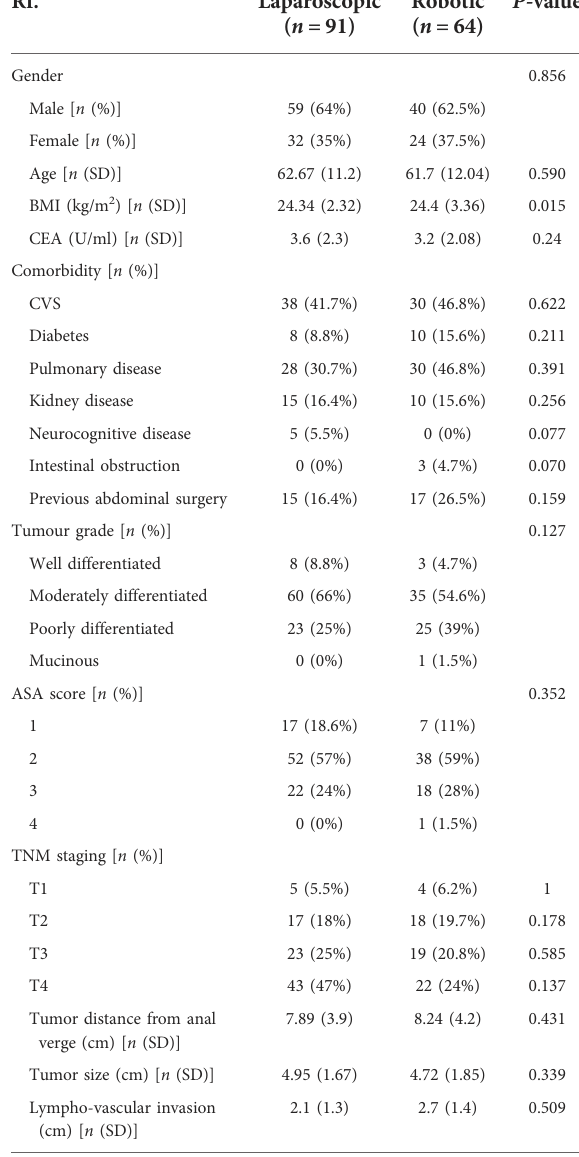
TABLE 1 Patient ’ s demographic